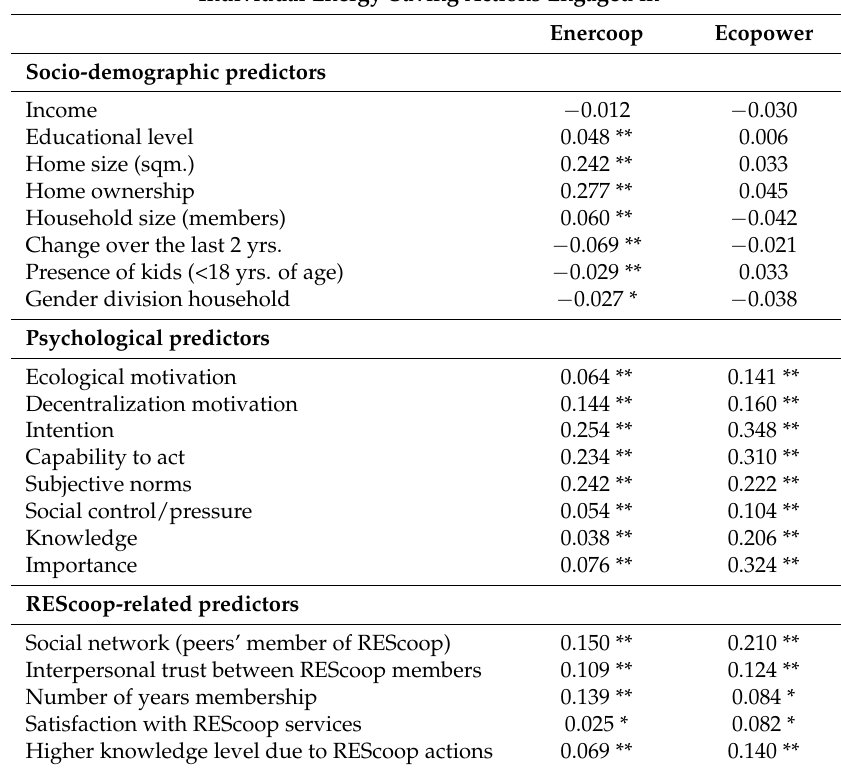
Table 6. Correlations for selected predictors and the sum of energy-saving actions REScoop members engaged